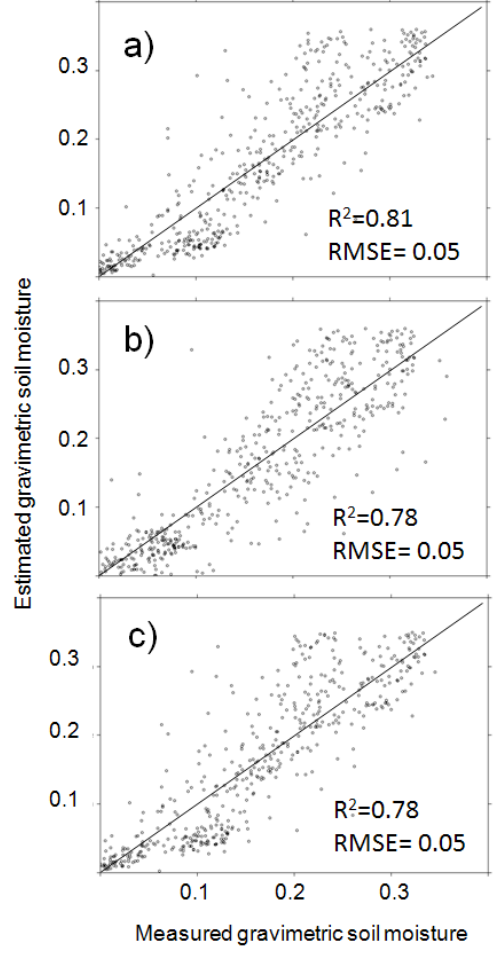
Figure 3. Plots of measured vs. estimated gravimetric soil moisture content by using ( a ) SMIR_A, ( b ) SMIR_B and ( c ) NSMI narrow band indices. In the graphs the 1:1 lines are